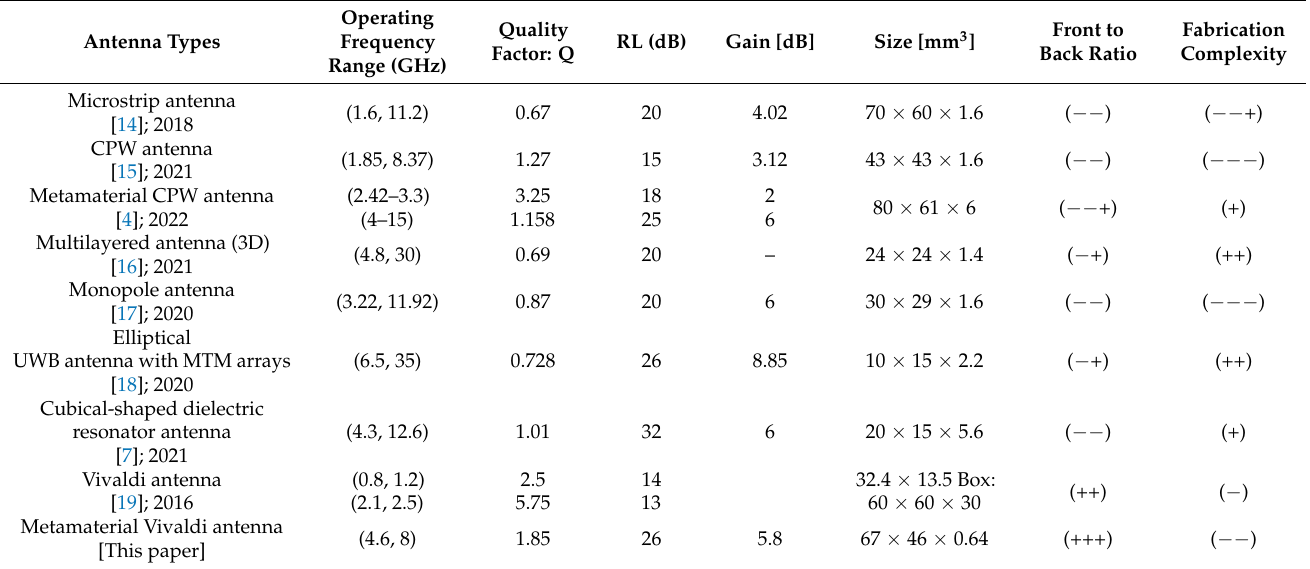
Table 3. Comparison study of the proposed work with some existing antenna used for breast cancer detection.